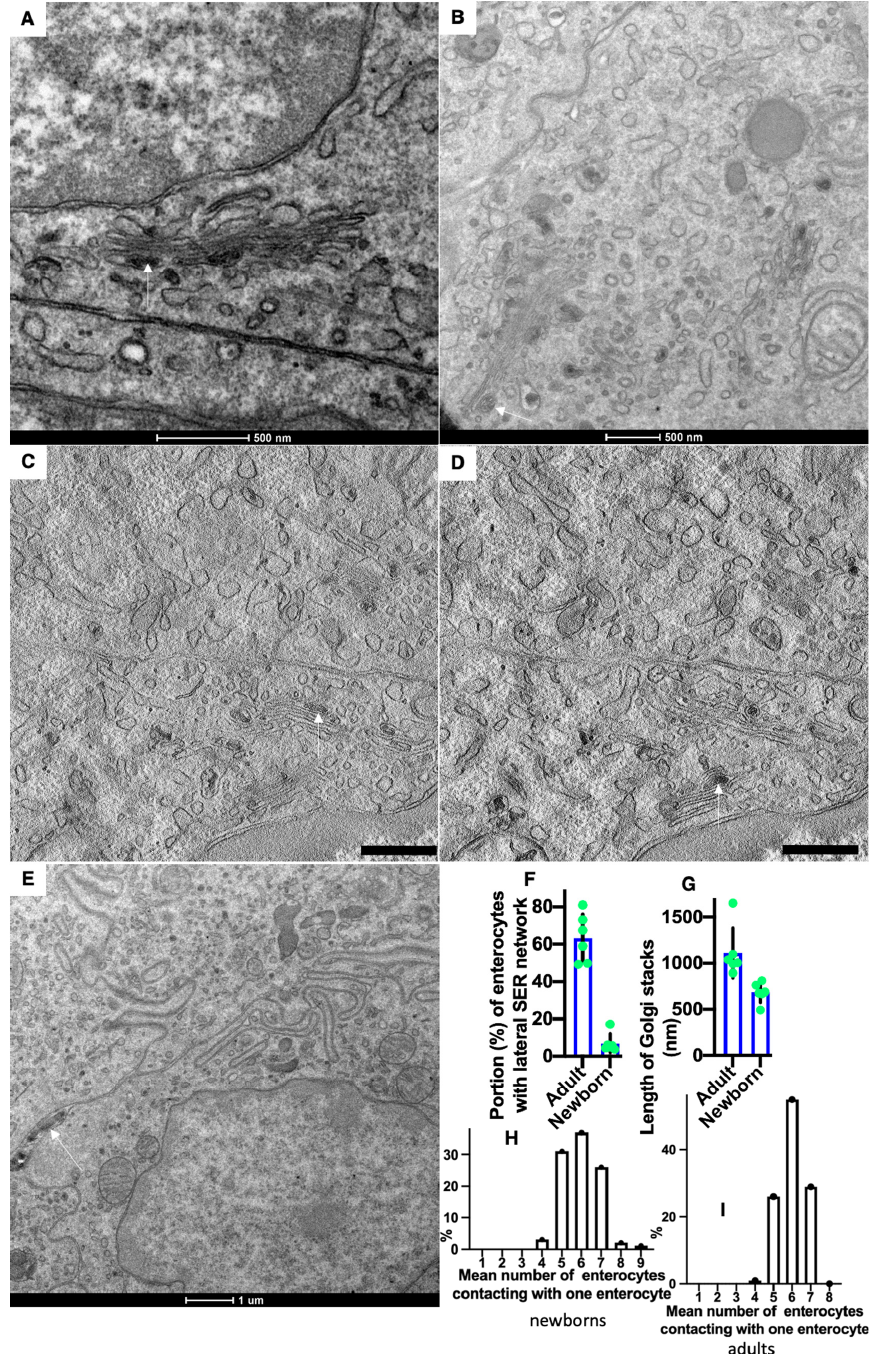
Figure 3. Structure of Golgi complex (GC) and vascular walls in newborn rats before their first feeding. ( A , B ) Routine Epon sections. ( C , D ) Serial tomographic slices. Multilamellar structures (arrows) are visible in the cisternal distension of the GCs. ( E ) Membrane remnants (white arrow) are visible inside the contact space between enterocytes. ( F ) The graph shows that in newborn rats, lower ( p < 0.05) number of enterocytes exhibited lateral SER network. ( G ) The graph shows that in newborn rats, the length of Golgi stacks was lower ( p < 0.05). ( H , I ) Graphs show the distribution of the mean number of neighbors of one enterocyte in newborn ( H ) and adult ( I ) rats. In the newborn rats, the shift of these distributions towards the low number is significant ( p < 0.05). Scale bars: 465 nm ( C , D ). In ( A , B , E ), scale bars are indicated below each